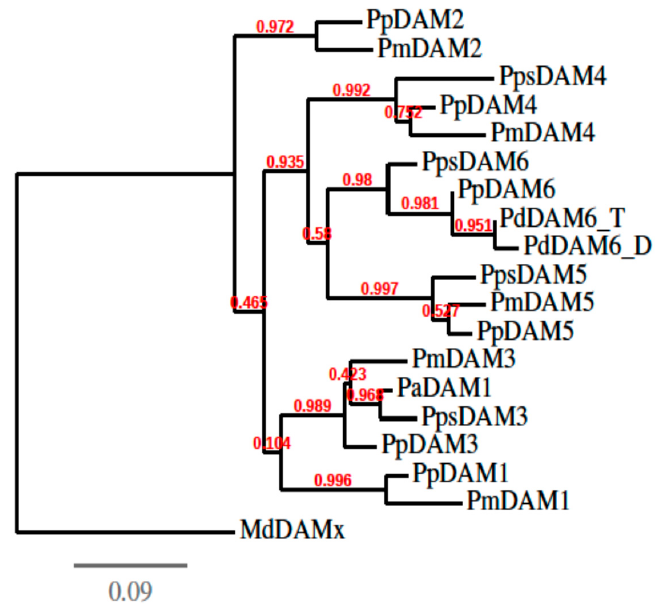
Figure 3. Phylogenetic tree showing relationships between homologous proteins to ‘Desmayo Largueta’ (PdDAM6_D) and ‘Penta’ (PdDAM6_P) sequence. Prunus persica (Pp), Prunus mume (Pm), Prunus pseudocerasus (Pps) and Prunus avium (Pa). aLRT (approximate likelihood ratio) values are indicated in red. Malus domestica DAM protein sequence (MdDAMx) was used as outgroup to root the phylogenetic tree.